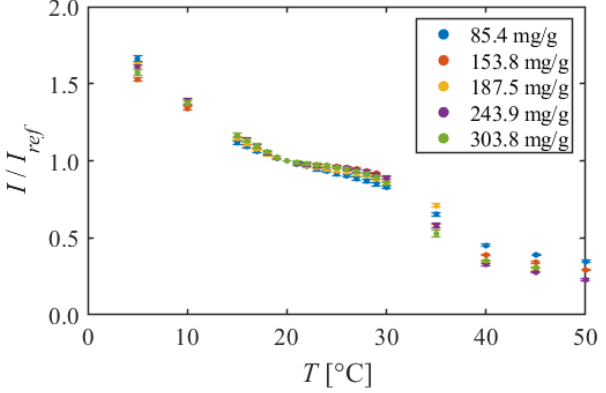
Figure 8. Calibration curves of PMMA + EtOH + DCM in different dye concentrations. The reference condition is T = 20 °C and P = 100 kPa.